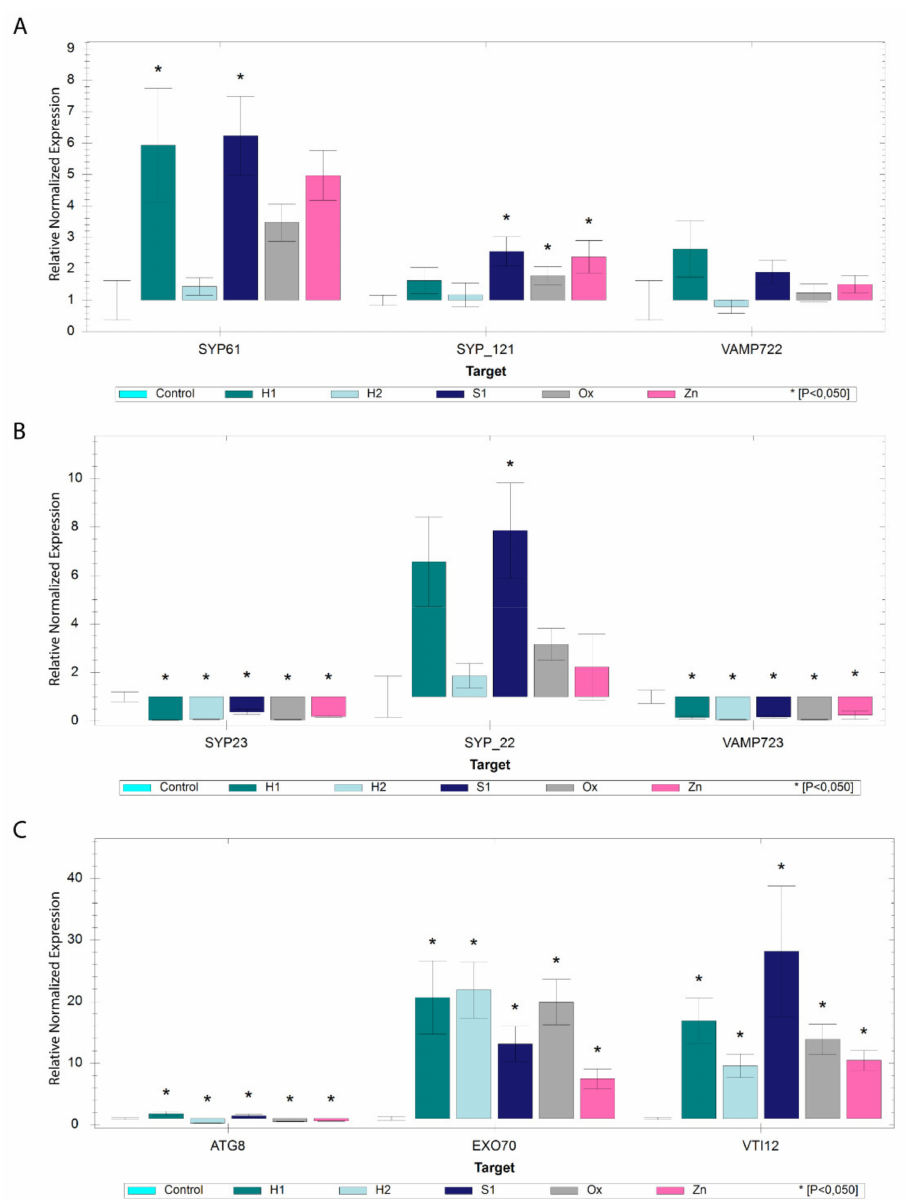
Figure 6. Expression analysis by qRT-PCR of genes involved in plasma trafficking and autophagy/ exocyst-mediated routes. ( A ) Bar chart analysis of AtSYP61 , AtSYP121 and AtVAMP722 genes involved in cell membrane trafficking processes in different stress conditions relative to control. ( B ) Bar chart analysis of AtVAMP723 , AtSYP23 and AtSYP22 genes in different stress conditions relative to control. ( C ) Bar chart analysis of AtExo70 , AtVTI12 and AtATG8 genes involved in exocytosis and autophagy processes in different stress conditions relative to control. * indicates statistically experimental values ( p <